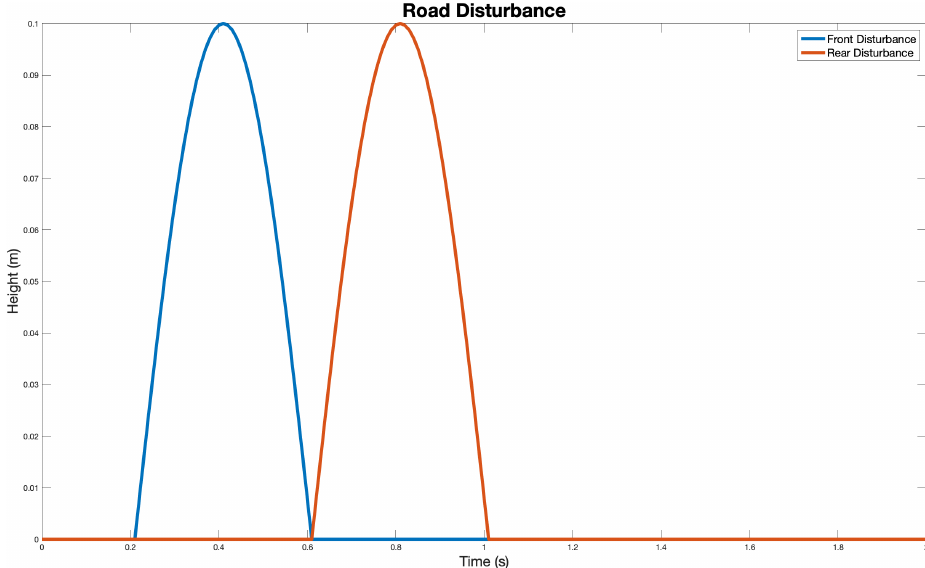
Figure 5. Road disturbance effect in both wheels of the half-car active suspension